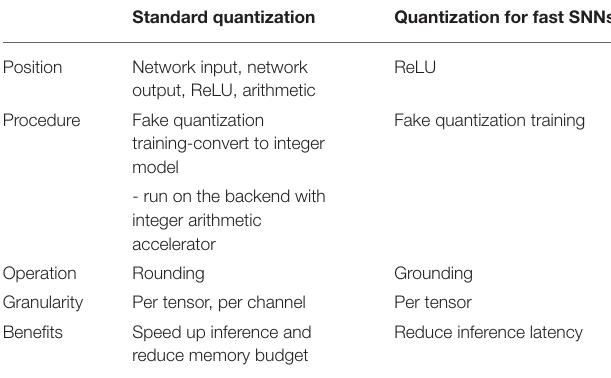
TABLE 1 | The main differences between general quantization techniques and the quantization techniques for fast